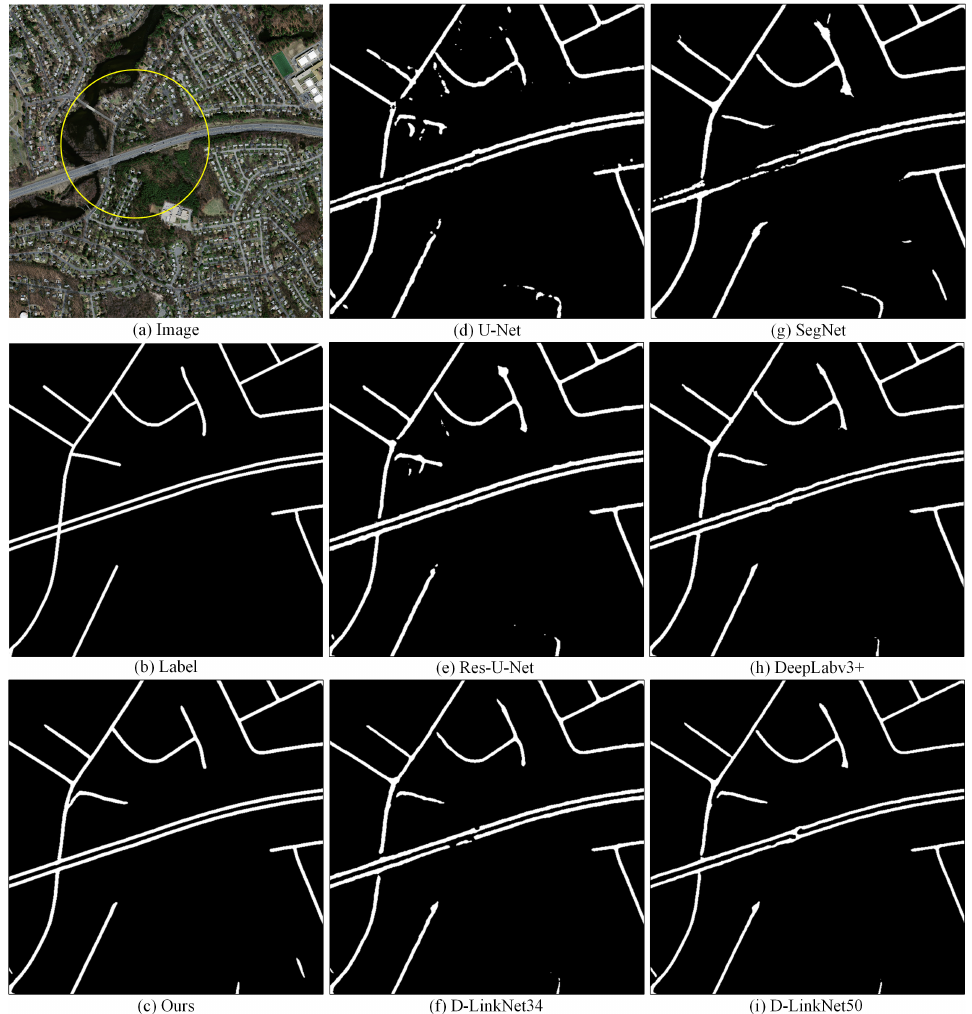
Figure 10. Local detail comparison on the Massachusetts dataset. Subparts ( d – i ) show the results of related methods corresponding to the area in the original image ( a ) marked with yellow. Subparts ( b , c ) are the ground truth and our